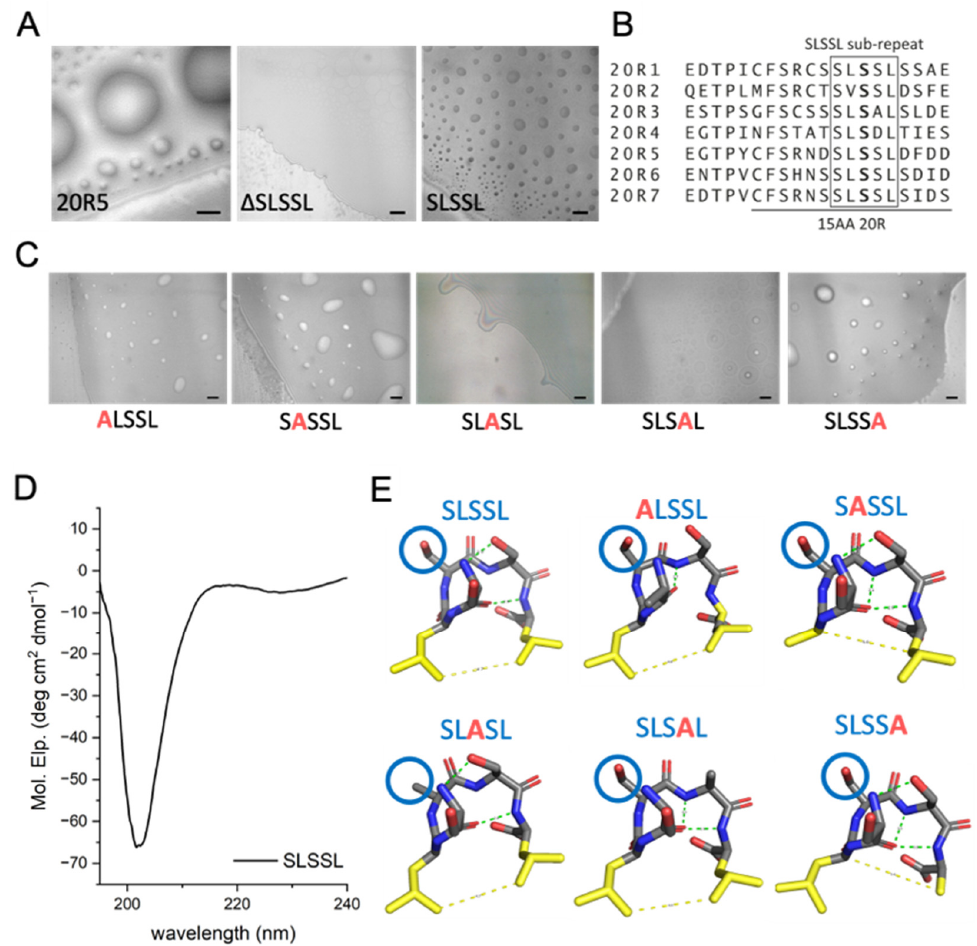
Figure 5. The SLSSL sequence, and particularly the 3rd serine in the sequence, are essential for LLPS of the 20R peptides. ( A ) Imaging of 20R5, SLSSL, and Δ SLSSL using DIC microscopy reveals an important role for SLSSL in droplet formation of 20R5. Scale bar = 20 µm. ( B ) Sequence alignment of all the 20R peptides show that the SLSSL, especially the 1st and the 3rd serines, are present in all 20R repeats. ( C ) Alanine scan of SLSSL at an ionic strength of 36 mM showed that ALASL, and SLSAL did not form droplets, while ALSSL, SASSL, and SLSSA formed droplets. Scale bars = 20 µm. ( D ) CD spectrum of SLSSL sub-repeat shows that it has a minimum at 203 nm, suggesting it forms a β -turn secondary structure. ( E ) Predictions from PEP-FOLD3 [43] show that all of the SLSSL peptides produced by alanine scanning are predicted to have a β -turn secondary structure. The 3rd serine is labeled with a blue circle.